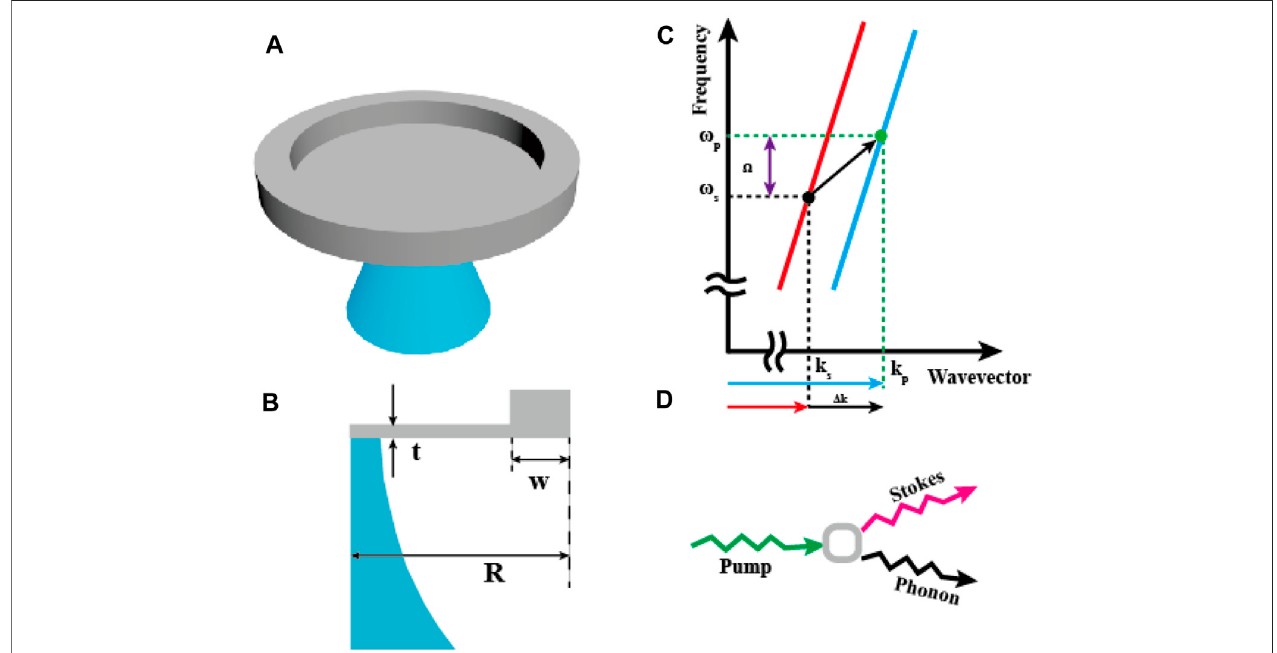
FIGURE1|(A) Structural diagramofmicroring cavitysystem. (B) Designdrawingofring cavity: t (cid:1) 250 nm, w (cid:1) 100 nm,Siradius correspondingtoR (cid:1) 5 µm. (C) Schematic diagram of the optical dispersion diagram. The optical resonance is represented by discrete points (black and blue) along the overall dispersion curve. The lowerarrowindicatestheresonanceopticaltransitionfrompumplight( k p )toStokeslightmode( k s )duetoSBS. (D) Whentheopticalfrequencymatchesthemechanical acousticmode,thephasematchingandenergyconservationofStokesprocessaredescribedbythephotondensityofstate(PDOS)andtheacousticfrequency Ω .